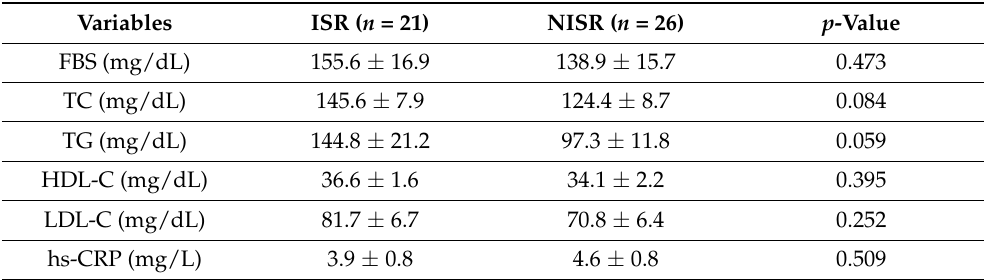
Table 3. Comparison of biochemical parameters between studied